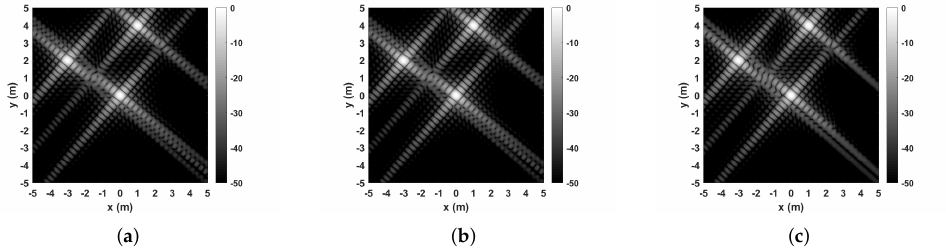
Figure 11. Images from the point target dataset generated using the backprojection algorithm, matched filter algorithm and fast-factorized backprojection algorithm. ( a ) Point target dataset im- age generated using the backprojection algorithm. ( b ) Point target dataset image generated using the matched-filter algorithm. ( c ) Point target dataset image generated using the fast-factorized backprojection